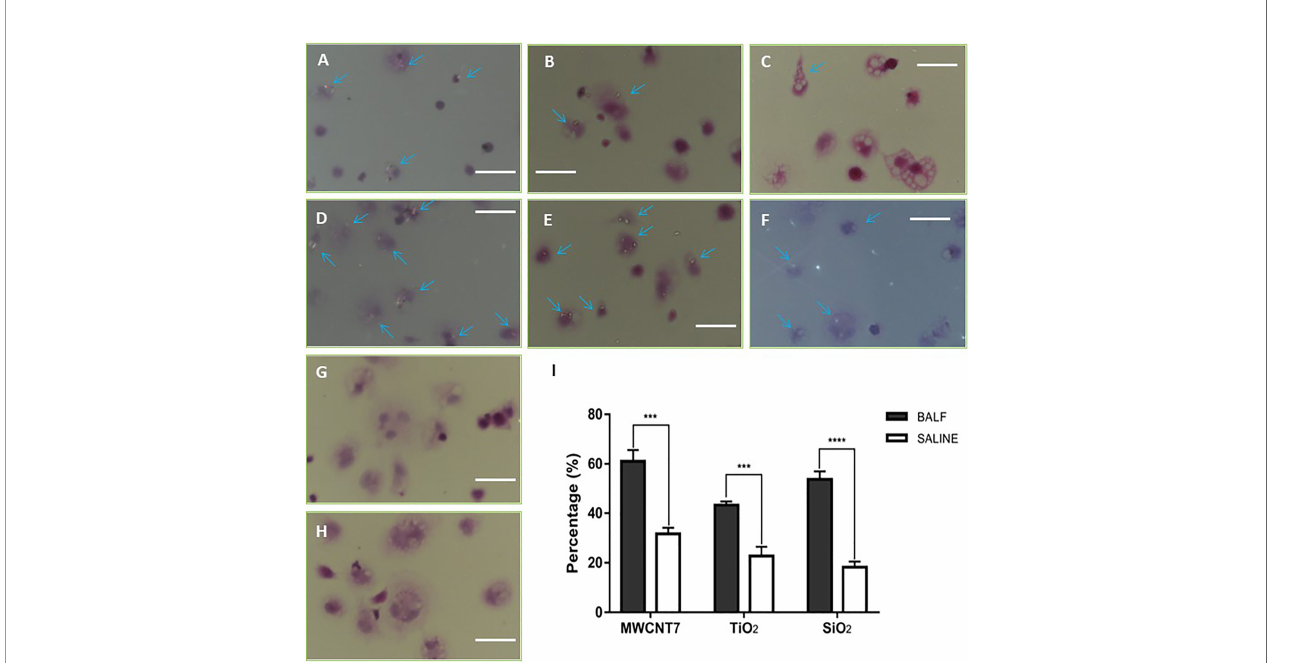
FIGURE 2 | In fl uence of BALF on phagocytosis of ENMs by primary alveolar macrophages. Primary alveolar macrophages were exposed in vitro to 4 types of ENMs (MWCNT-7, TiO 2 , SiO 2 , and C60) in the absence (A – C, G) or presence (D – F, H) of BALF. Phagocytosis of ENMs was examined by polarized light microscopy under 40×mani fi cation. (A, D) , specimens from an MWCNT-7 treated rat, (B, E) , specimens from a TiO 2 treated rat. (C, F) , specimens from an SiO 2 treated rat. (G, H) specimens from a C60 treated rat. Arrows indicate alveolar macrophages with phagocytosed ENMs; bars = 50 m m. C60 is isotropic, and therefore, C60 cannot be speci fi cally identi fi ed by polarized microscopy. Consequently, only percentages of alveolar macrophages with phagocytosed MWCNT-7, TiO 2 , and SiO 2 were calculated (I) . *** and **** represent p values less than 0.001 and 0.0001,